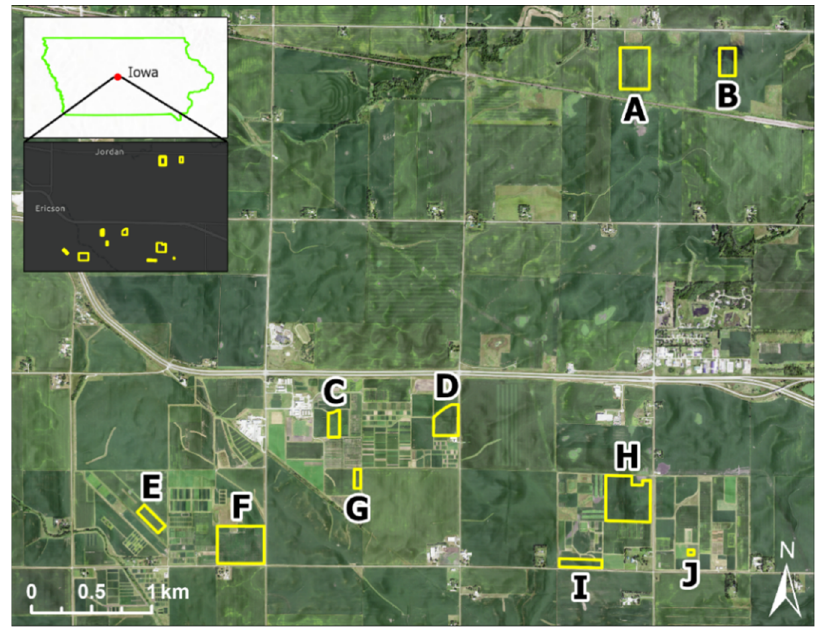
Figure 1. Map of the study fields ( A – J ). Size of the fields ranged from 0.4 ha to 13.1 ha. Soil samples were collected from these fields with a grid-sampling design. Fields ( A , B , F ) had 25 by 25 m grids. Field ( C ) used 20 by 20 m grids. Fields ( D , E , G ) used 15 m grids. Field ( H ) had a 37.5 m grid. Field ( I ) used a 10 by 28 m grid. Field ( J ) used a 5 m grid.